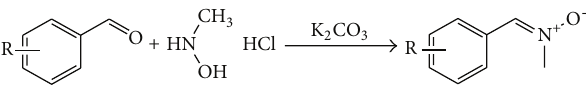
Scheme 1: Synthesis of phenyl nitrone derivatives.